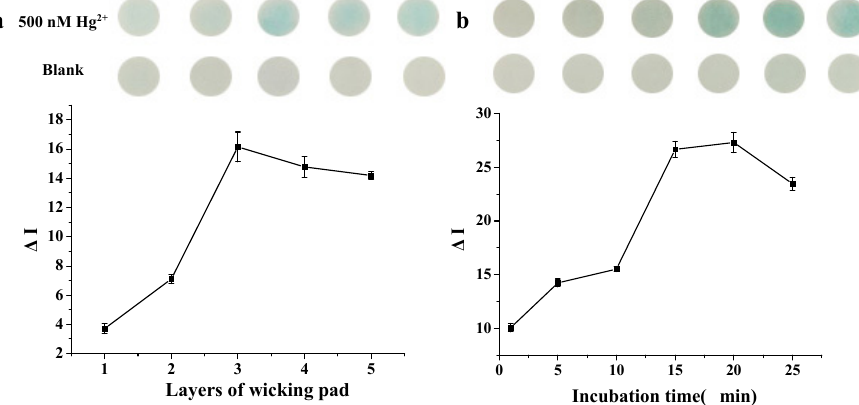
Figure 4. Optimization of the Hg 2+ volume and adsorption time. ( a ) Effect of layers of wicking pad and ( b ) effect of incubation time.